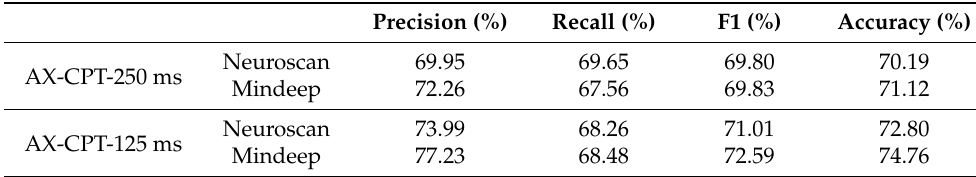
Table 3. Comparison of attention classification models for Neuroscan and Mindeep in AX-CPT-250 ms and AX-CPT-125 ms